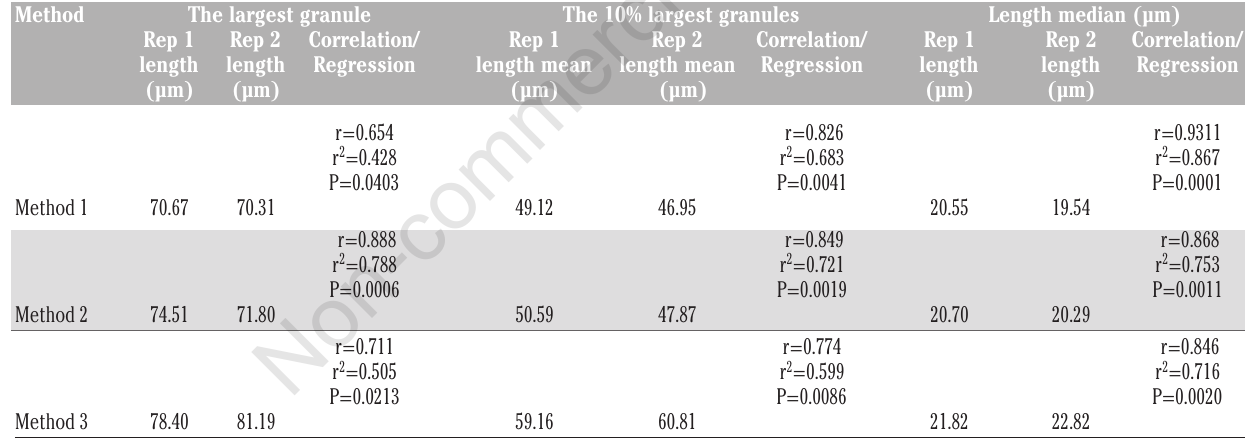
Table 3. The lengths of the single largest starch granule, the 10% largest starch granules, the median value of measurable starch gran- ules, and reproducibility between repeated experiments. a